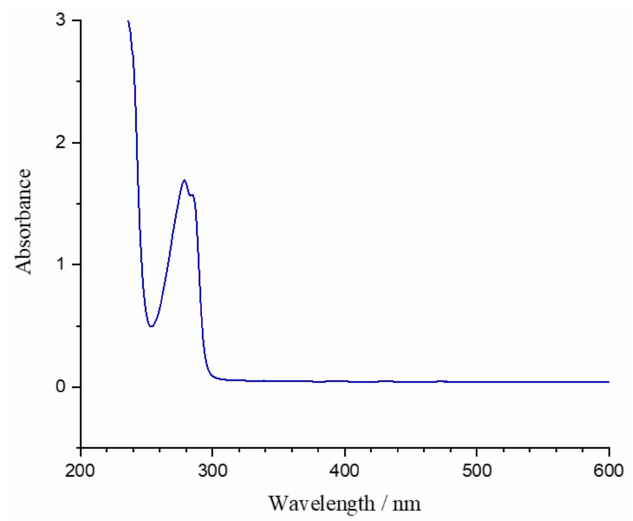
Figure 3. Optical absorption spectrum of SU-8